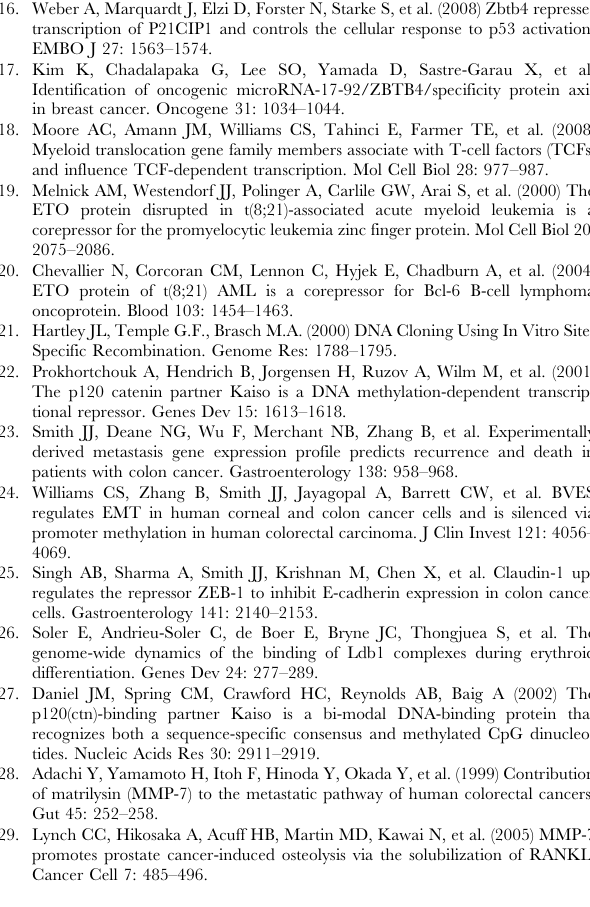
Figure S7 MTG family members repress endogenous MMP-7 expression in Cos7 cells. MMP-7 mRNA expression after transfection of the indicated MTG family member in Cos7 cells. The graph shows the fold-change ( DD Ct) of MMP-7 mRNA compared to an empty control. Error bars represent the standard error for three replicate experiments performed in